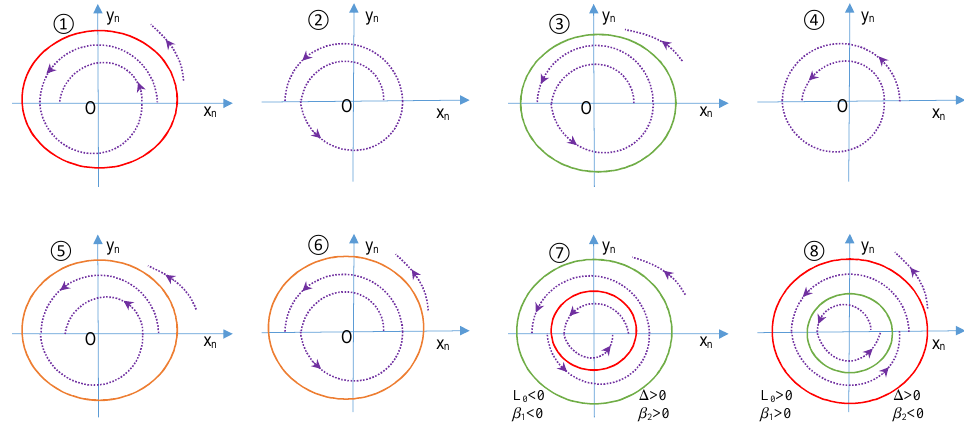
Corresponding to the studies we previously carried out [4,15], the following phase portraits are highlighted below. In this case, the phase portraits for the curves of bifurcation when ∆ ( α ) = 0 are shown in Figure A1.